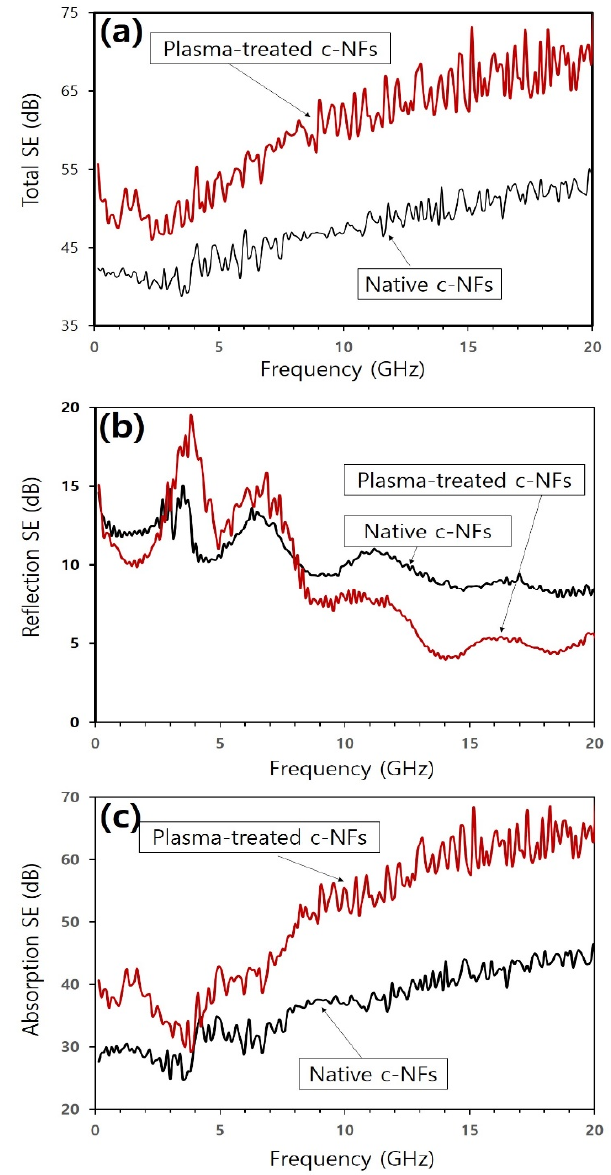
Figure 7. ( a ) Total shielding effectiveness (SE) spectra; ( b ) components of SE spectra owing to reflection; and ( c ) components of SE spectra owing to absorption for both native and plasma-treated c-NFs